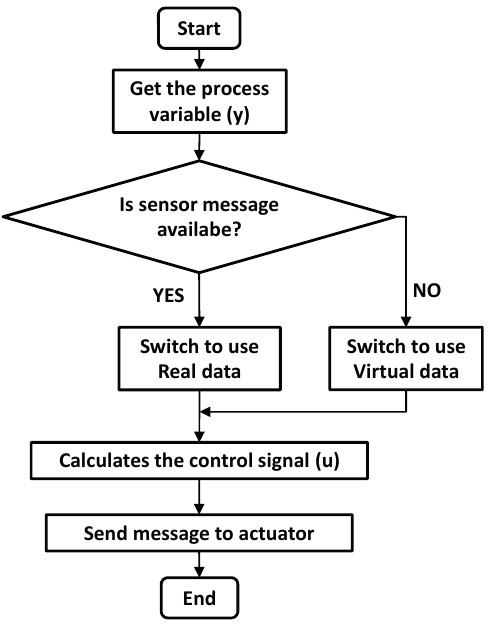
Figure 3. Flowchart of the model-based multi-rate control